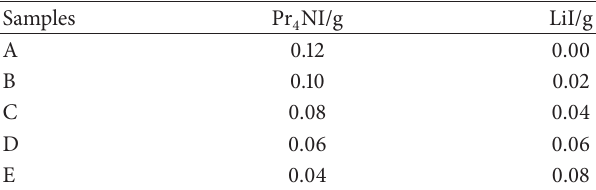
Table 2: Composition of the salts in binary salt